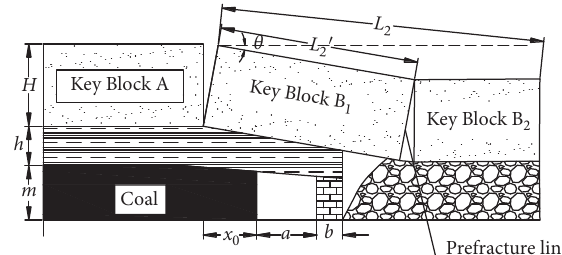
Figure 4: Hydraulic fracturing pressure relief mechanism.